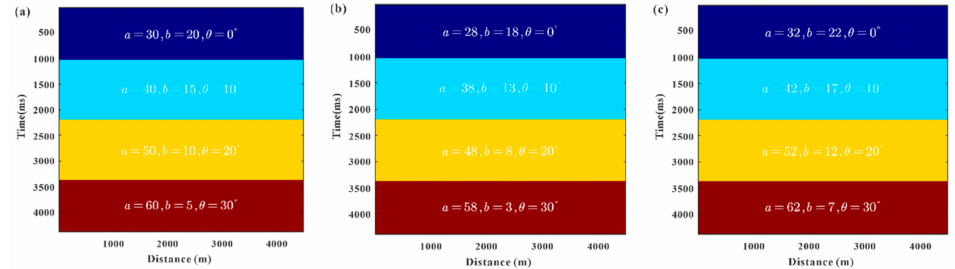
Figure 2. Autocorrelation parameters: ( a ) porosity, ( b ) clay volume, ( c ) water